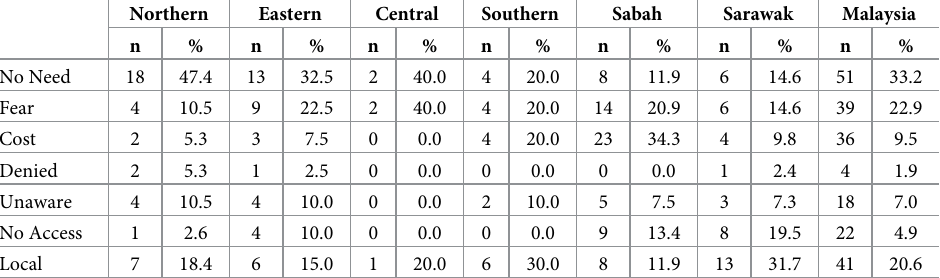
Table 5. Patient perceived barriers to cataract